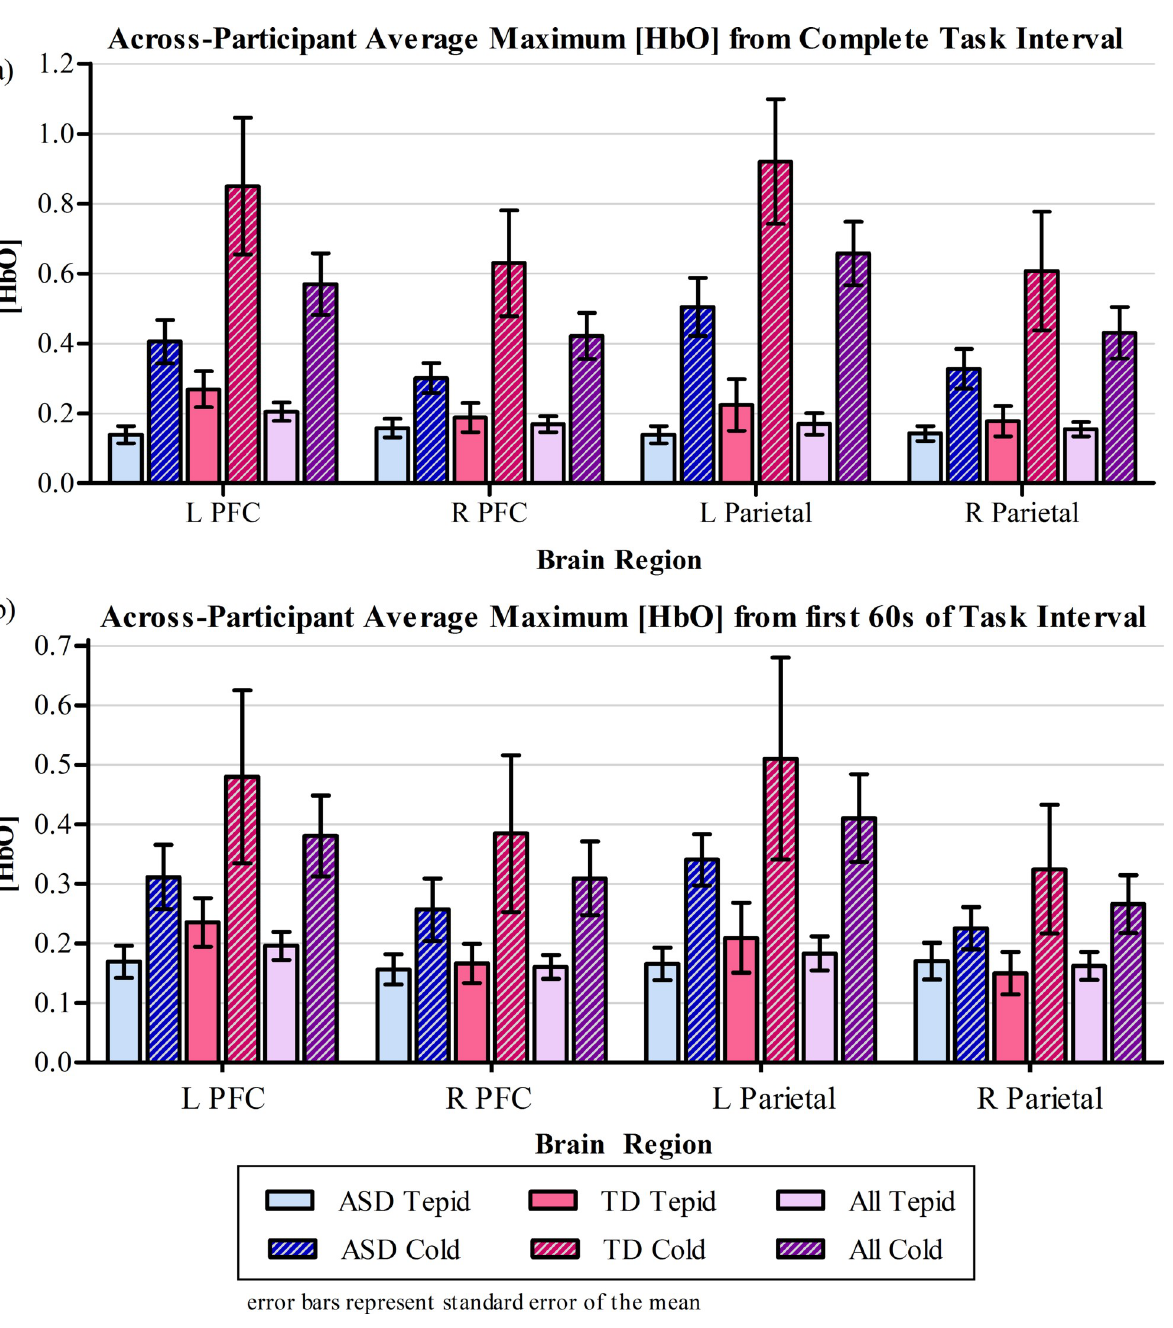
Fig 5. Across-participant average functional brain response a) from the full task trials and b) from the first 60s of the task trials. The peak relative [HbO] of the cold-water or tepid-water trials were average for each of the cold-water and tepid-water trials for each of the 4 brain regions, for each study group. Error bars represent standard error of the